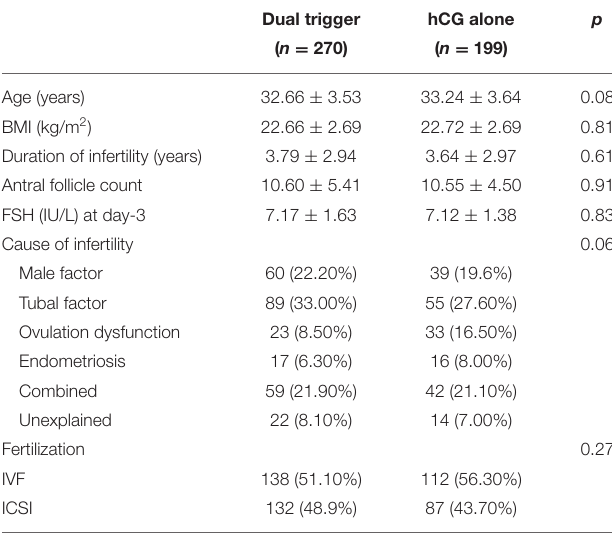
TABLE 1 | Comparison between the dual-trigger group and hCG-alone group: characteristics of patients at